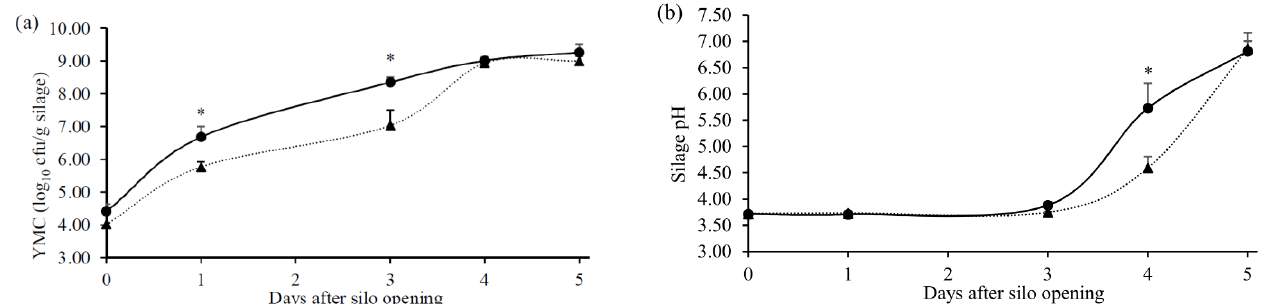
Figure 1. Changes in ( a ) yeast and mold counts (YMC) and ( b ) pH of 105-d ensiled laboratory-scale forages during aerobic exposure. Corn silage was treated without ( , n = 3) or with ( , n = 3) DPI. Values with asterisk (*) within the same aerobic exposure time differed significantly ( p < 0.05). Data were presented as mean ± SEM. Table 1. Effects of inoculant application 1 on the quality and chemical composition of laboratory minisilos at different ensiling periods.